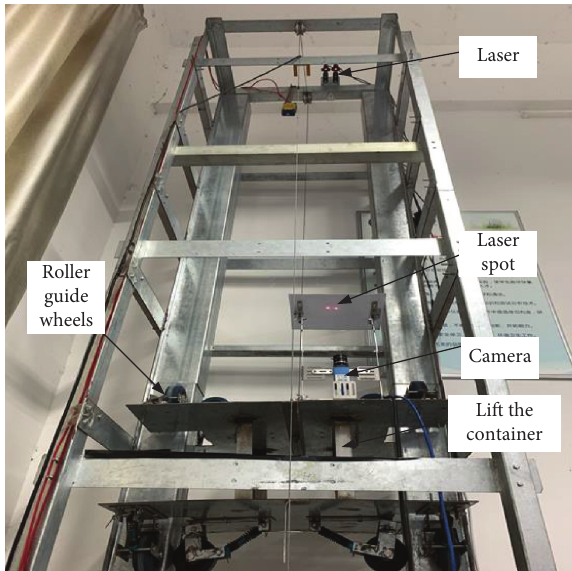
Figure 2: Vertical shaft rigid can way test bench based on the laser vision system.